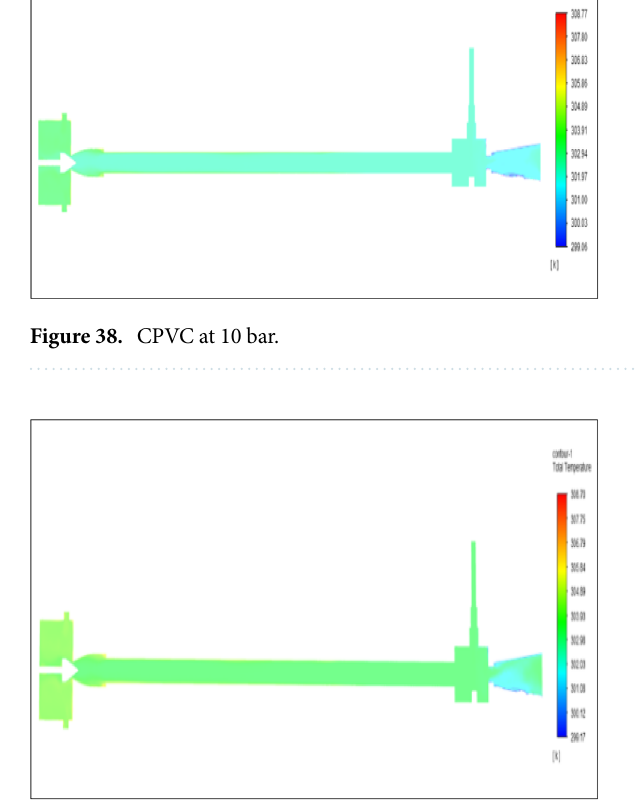
Figure 39. Acrylic at 10 bar.